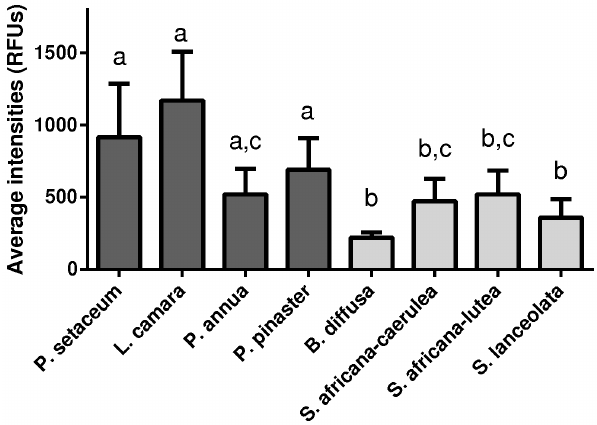
Figure 2. A comparison of mean fluorescence intensity ( ± standard error, SE) between the species sampled. No significant differences were found between the invasive species (dark grey). The four native species and Salvia hybrids (shown in light grey) differed significantly from all of the invasive species (with exceptions), but not from each other (Kruskal-Wallis Chi squared=125.9, df=8, P , 0.0001). Samples with the same letters do not differ significantly, whilst different letters indicate significant differences between the species and were determined with Dunn’s post hoc tests.